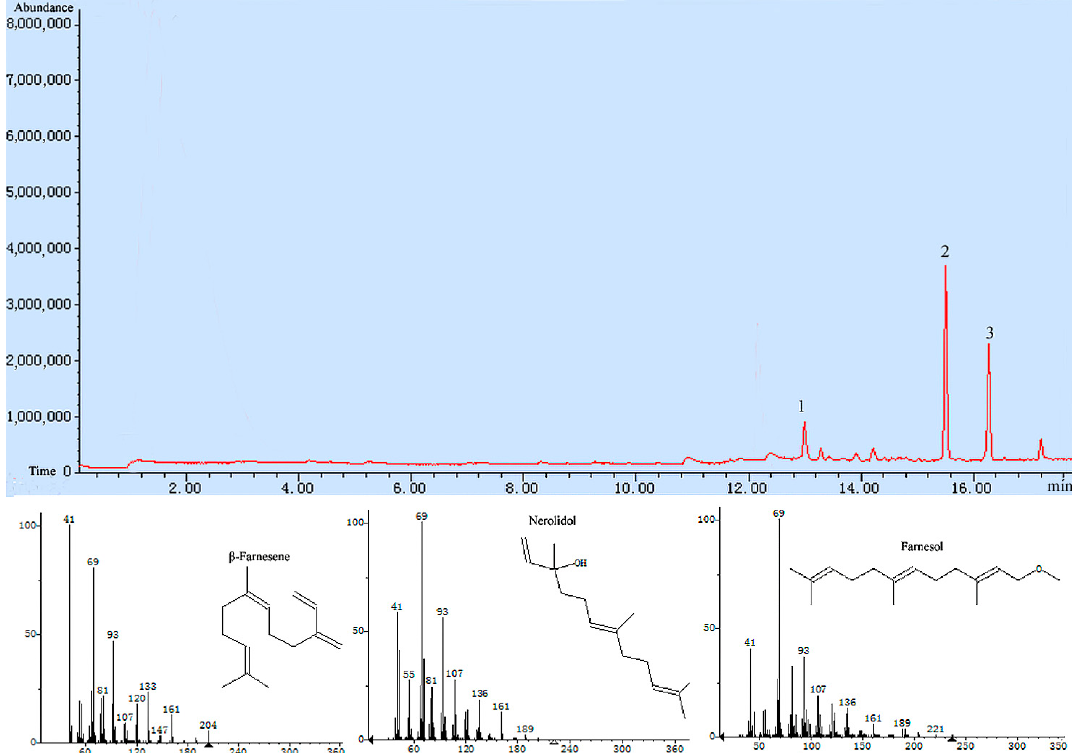
Figure 6. Products catalzyed by trichodiene synthase from M. roridum were detected by GC-MS: peaks 1, 2, and 3 corresponded to β -farnesene, nerolidol and farnesol, respectively.